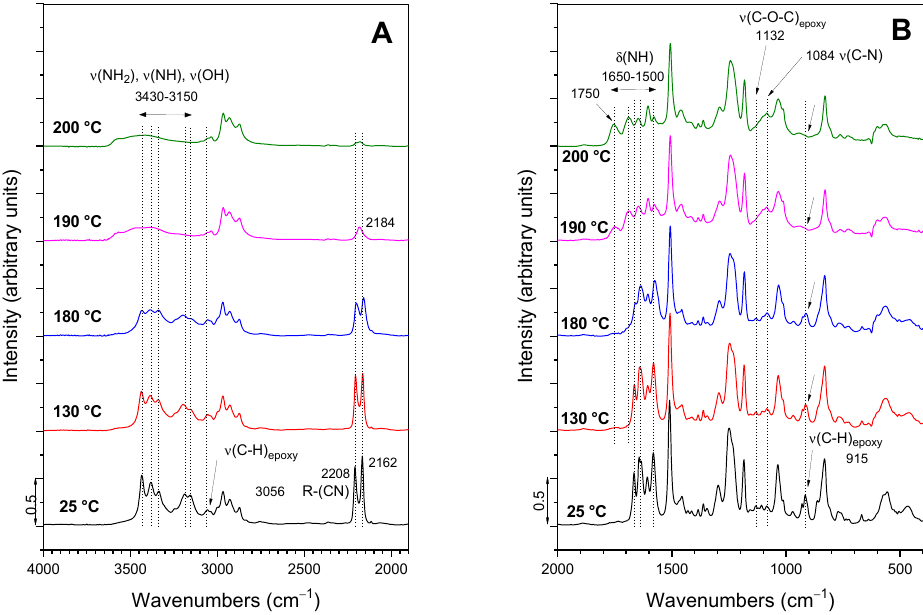
Figure 6. Time-dependent FT-IR absorbance spectra during the thermal curing process of formulation D in the spectral ranges: ( A ) 4000–1900 cm − 1 and ( B ) 2000–400 cm − 1 .